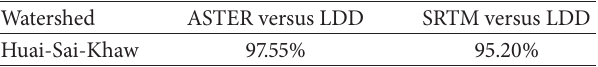
Figure 2: Watershed delineation for Huai-Sai-Khaw watershed. Table2:IntersectedareasbetweenvariousDEMsextractedinHuai- Sai-Khaw watershed.